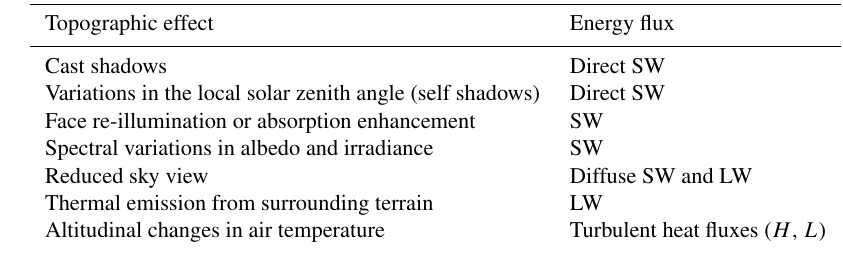
Figure 1. Illustration of the topographic effects considered in this study. They are summarized in Table 1. The colour code in the scheme that illustrates the lapse rate effect means decreasing temperatures with increasing elevation. Table 1. Several effects relevant to short-wave (SW), long-wave (LW), and turbulent heat flux calculation in complex terrains. Other effects such as those involving the atmosphere are beyond the scope of this